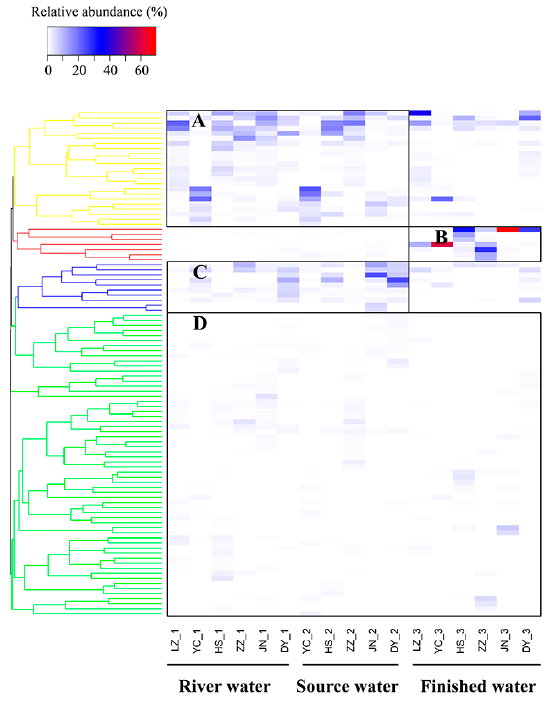
Figure 4. Heatmap of distribution profiles of bacterial genera across different water samples. Each row represents the results of genus percentage by sequencing. Dendrograms for the rows were constructed from the Bray-Curtis dissimilarity distance. Black boxes represent different patterns of genera: ( A ) widely detected in all water types, dominant in river and source water; ( B ) highly enriched in finished water, but rarely detected in river and source water; ( C ) mainly detected in river and source water, but not in finished water; and, ( D ) relatively low in all water types.